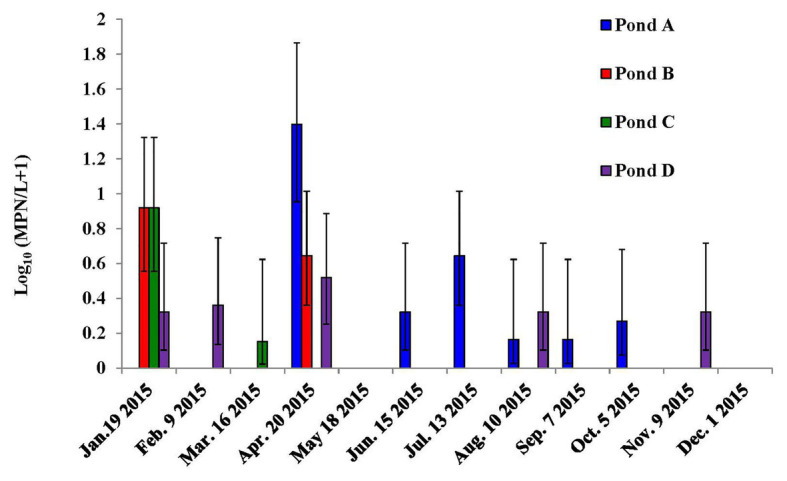
Dynamics of Listeria monocytogenes in the irrigation ponds of farms A–D on the Eastern Shore of Virginia (ESV). Bars represent 95% confidence intervals.